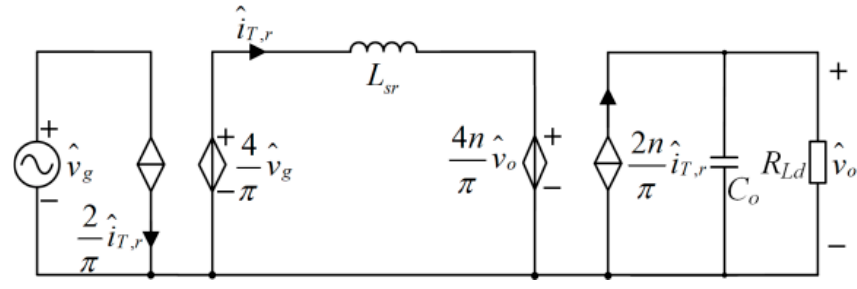
Figure 6. Simplified third-order small-signal model. Equation (10) shows that the current control-voltage source of the real part of the loop in Figure 6 can be replaced by impedance Z cs ( s ). It can be seen from (4) and (8) that Z cs ( s ) ≈ 0 is also valid. After Z cs ( s ) is substituted into Figure 6, the real part of the small- signal model is no longer coupled with the imaginary part. After the imaginary part is separated, the simplified second-order small-signal model of the full-bridge LLC resonant converter in DCT mode can be obtained, as shown in Figure 7.